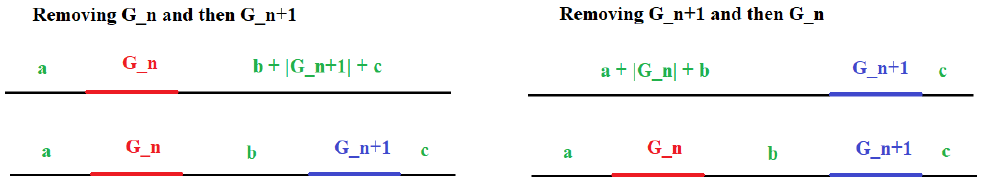
Figure 2. Removing gaps of equal length in two possible